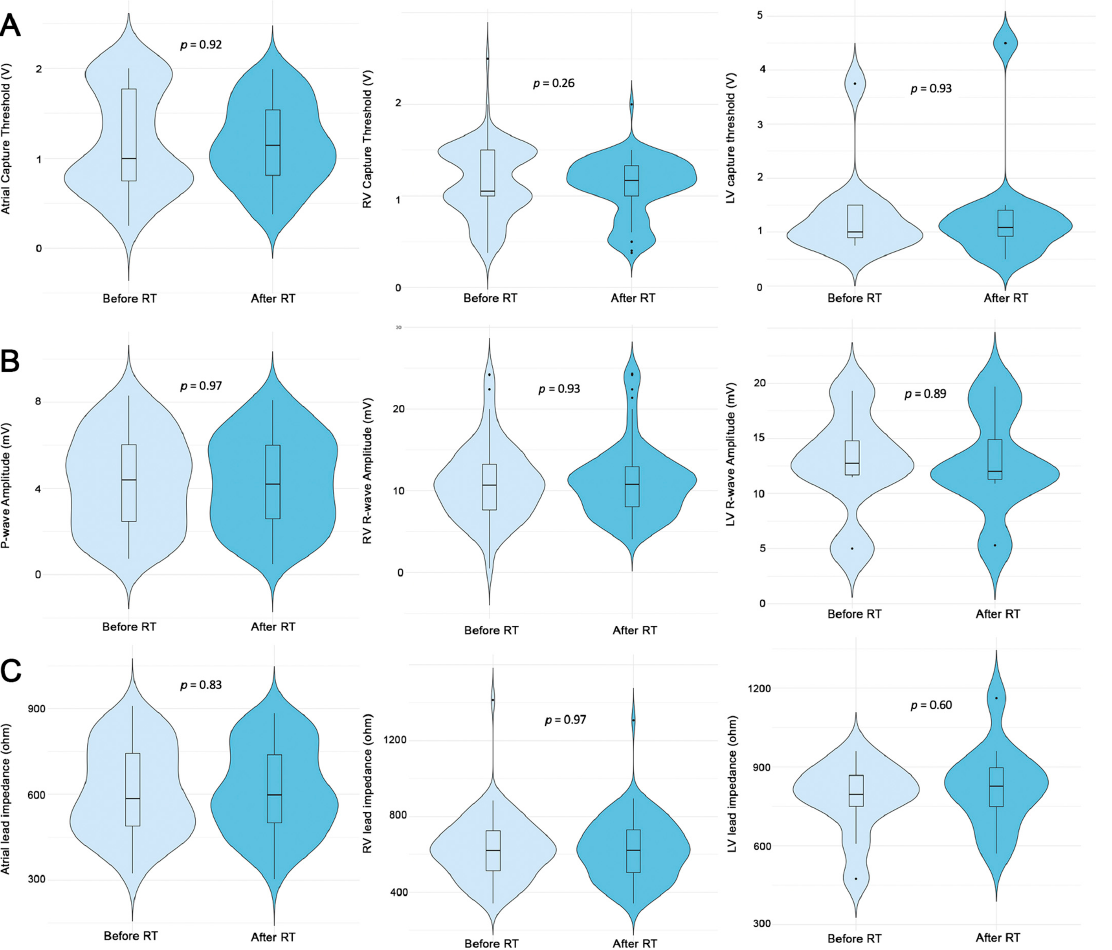
Figure 2. Changes in device parameters: capture thresholds ( A ), sensing amplitude ( B ), and leads impedance ( C ).